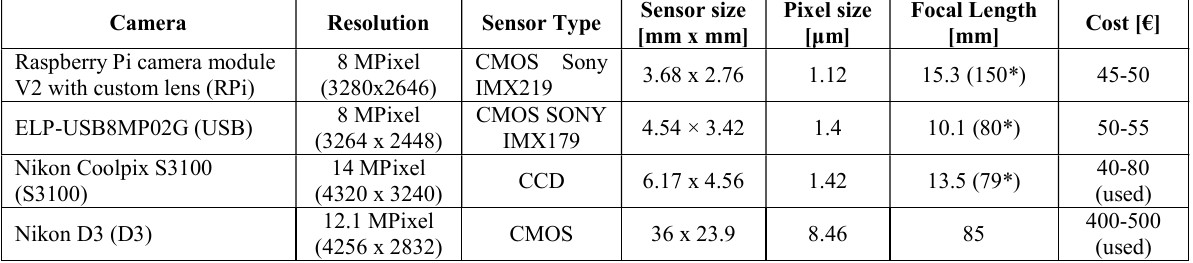
Table 1. Technical specifications of the four tested camera